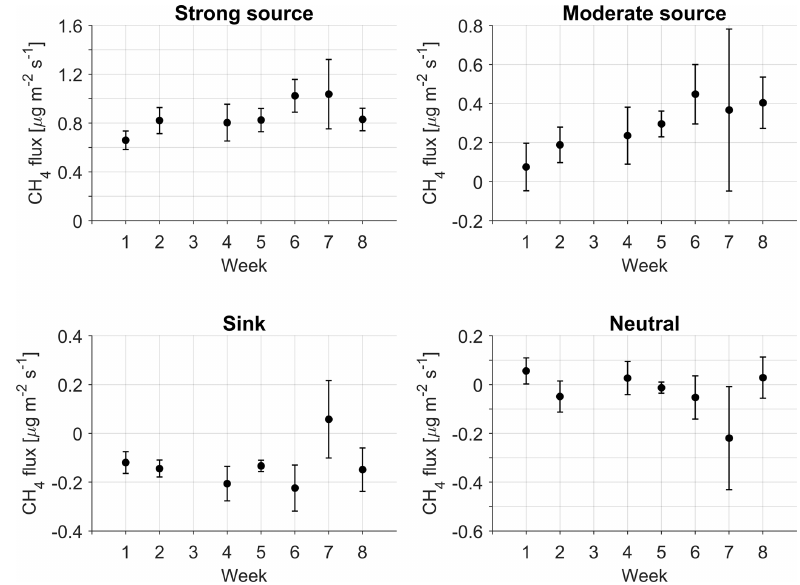
Figure 6. Estimates of the LCC group-specific fluxes calculated from weekly data (1 indicates 5–11 July; 2 indicates 12–18 July; 3 indicates 19–25 July, data missing; 4 indicates 26 July–1 August; 5 indicates 2–8 August; 6 indicates 9–15 August; 7 indicates 16–22 August; 8 indicates 23–29 August). The vertical bars indicate the 95% confidence intervals.